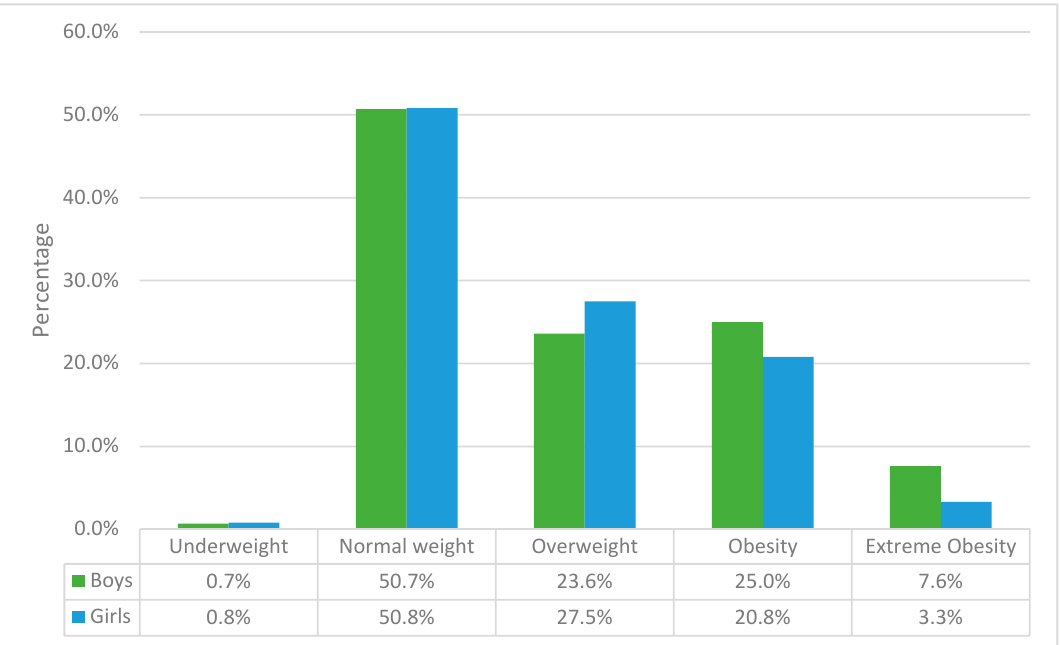
Figure 1. Frequency of weight according to sex.